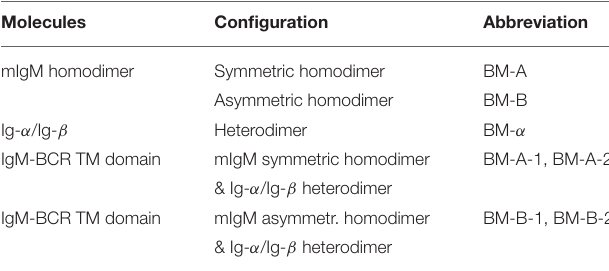
TABLE 3 | Dimer/oligomer configurations sampled in MD simulations and their